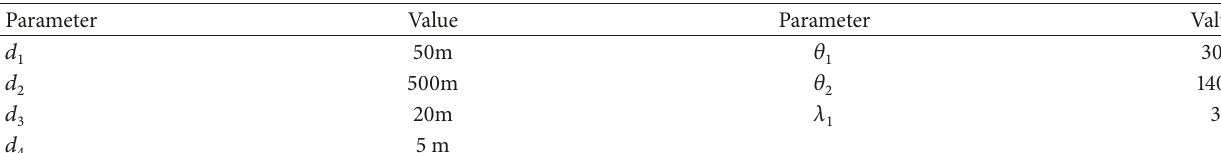
Table 3: Parameter values in trajectory merging.